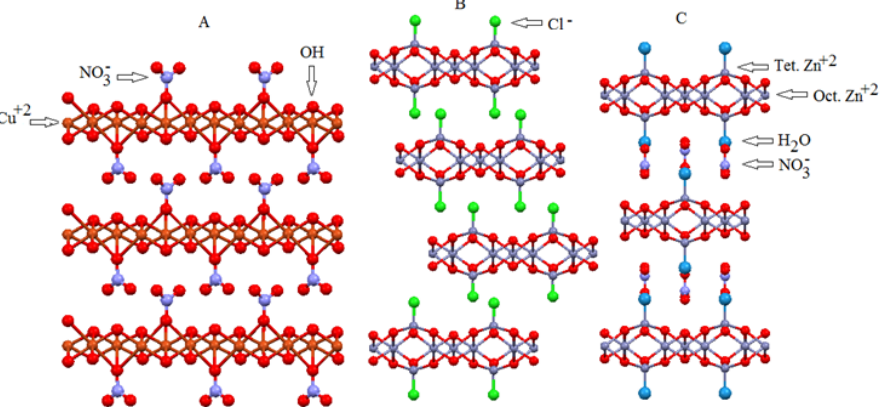
Figure 4. Side view of the structures of: ( A ) Copper hydroxite nitrate; ( B ) Zinc hydroxide chloride; ( C ) Zinc hydroxide nitrate. Hydrogen atoms were removed from the structure to facilitate visualization [36,37].